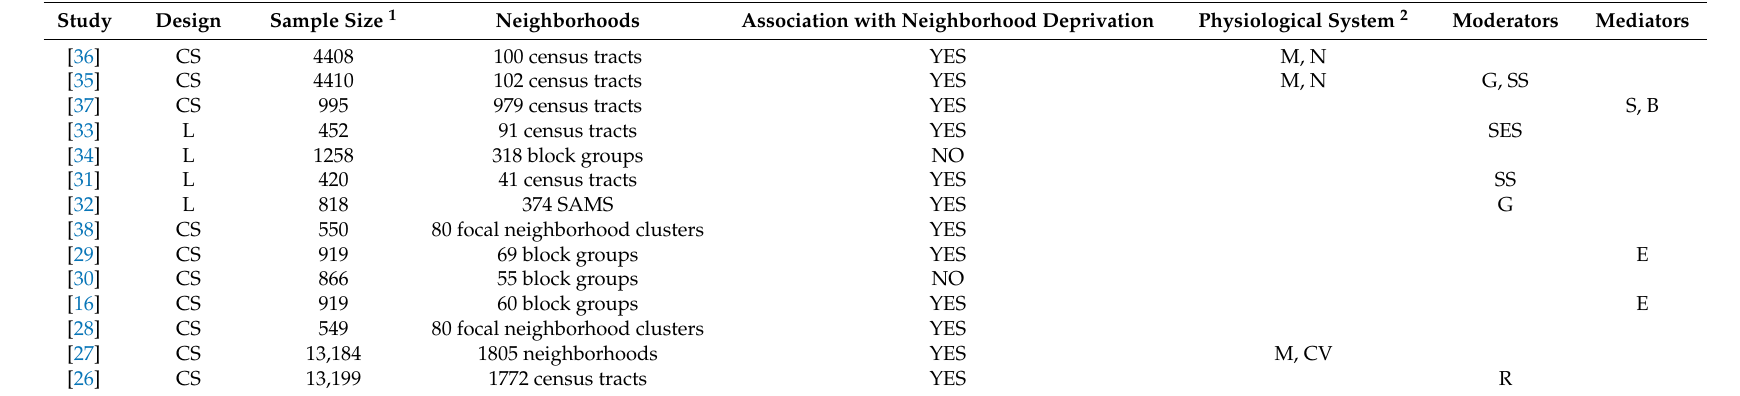
Table 1. Summary of the study